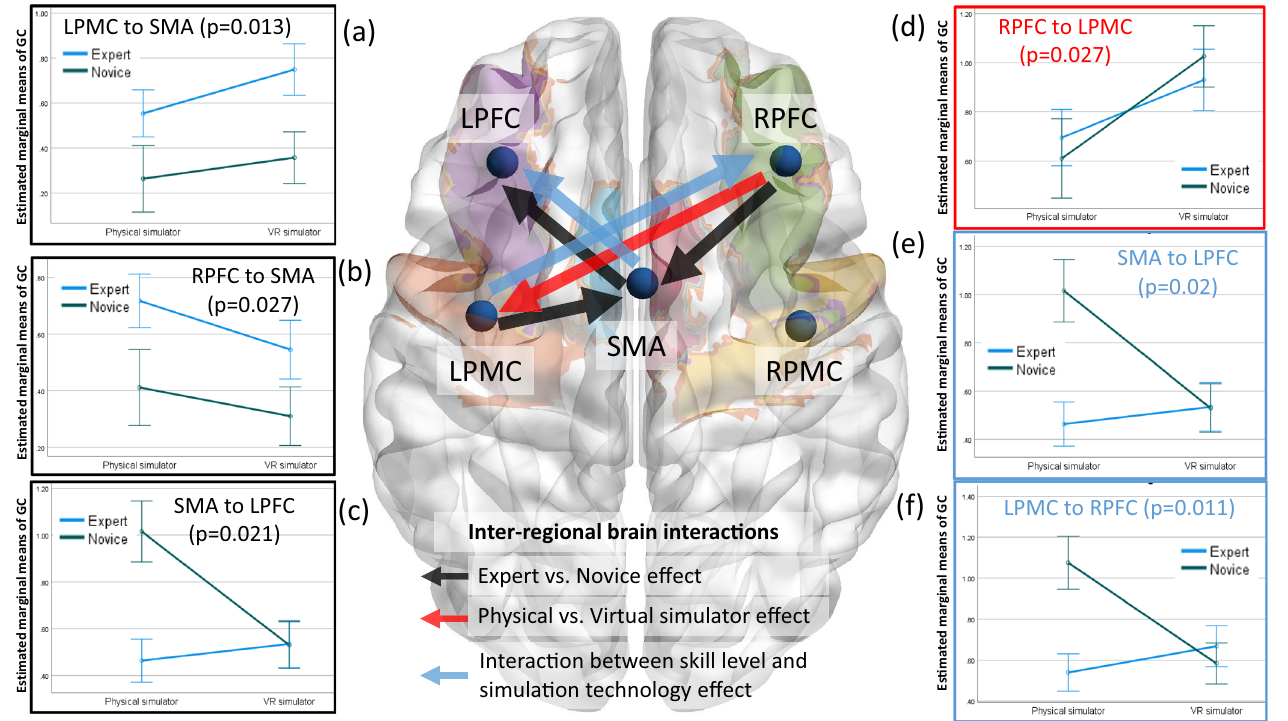
Fig. 2 Plots of the estimated marginal means of the signi fi cant interregional directed functional brain connectivity. Error bars show the standard error. a Signi fi cant ( p = 0.013) effect of skill level (expert, novice) on LPMC- to SMA-directed functional connectivity. b Signi fi cant ( p = 0.027) effect of skill level (expert, novice) on RPFC- to SMA-directed functional connectivity. c Signi fi cant ( p = 0.021) effect of skill level (expert, novice) on SMA to LPFC directed functional connectivity. d Signi fi cant ( p = 0.027) effect of the simulator technology (physical simulator, VR simulator) on RPFC-to-LPMC-directed functional connectivity. e Signi fi cant ( p = 0.020) effect of the interaction between skill level and the simulator technology on SMA to LPFC directed functional connectivity. f Signi fi cant ( p = 0.011) effect of the interaction between skill level and the simulator technology on LPMC-to-RPFC-directed functional connectivity. Signi fi cant (after controlling for a false discovery rate of 0.05 with Benjamini – Hochberg adjustment) interregional directed functional brain connectivity is shown with colored arrows for the factors, the skill level (expert, novice), simulator technology (physical simulator, VR simulator), and their